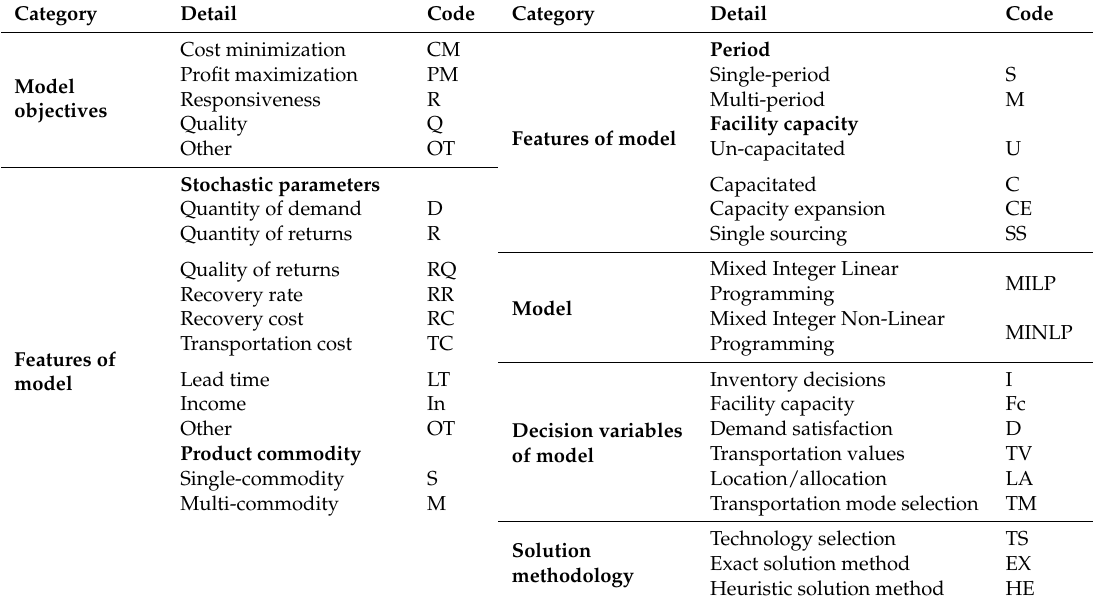
Table 1. Modeling approach codes.